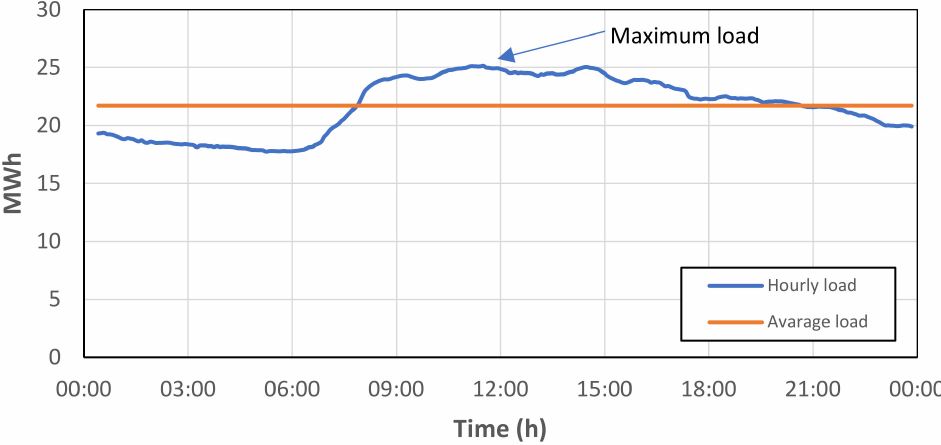
Figure 7. Daily average electrical energy consumption profile of KAU